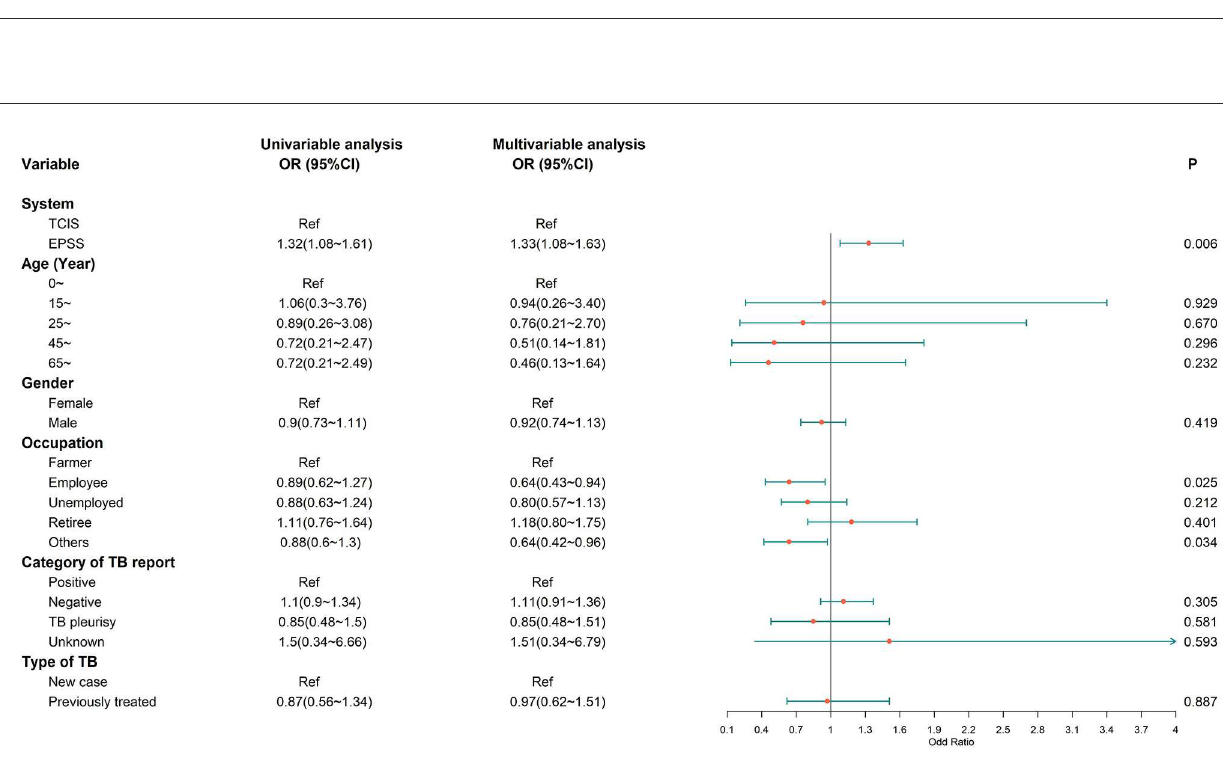
FIGURE4 Multivariate logistic regression analysis on the factors associated with good medication adherence. Good medication adherence, more than 80% doses taken during 6 months; OR, odds ratio; CI, confidence interval; model was adjusted for age, gender, occupation, category of TB report, and type of